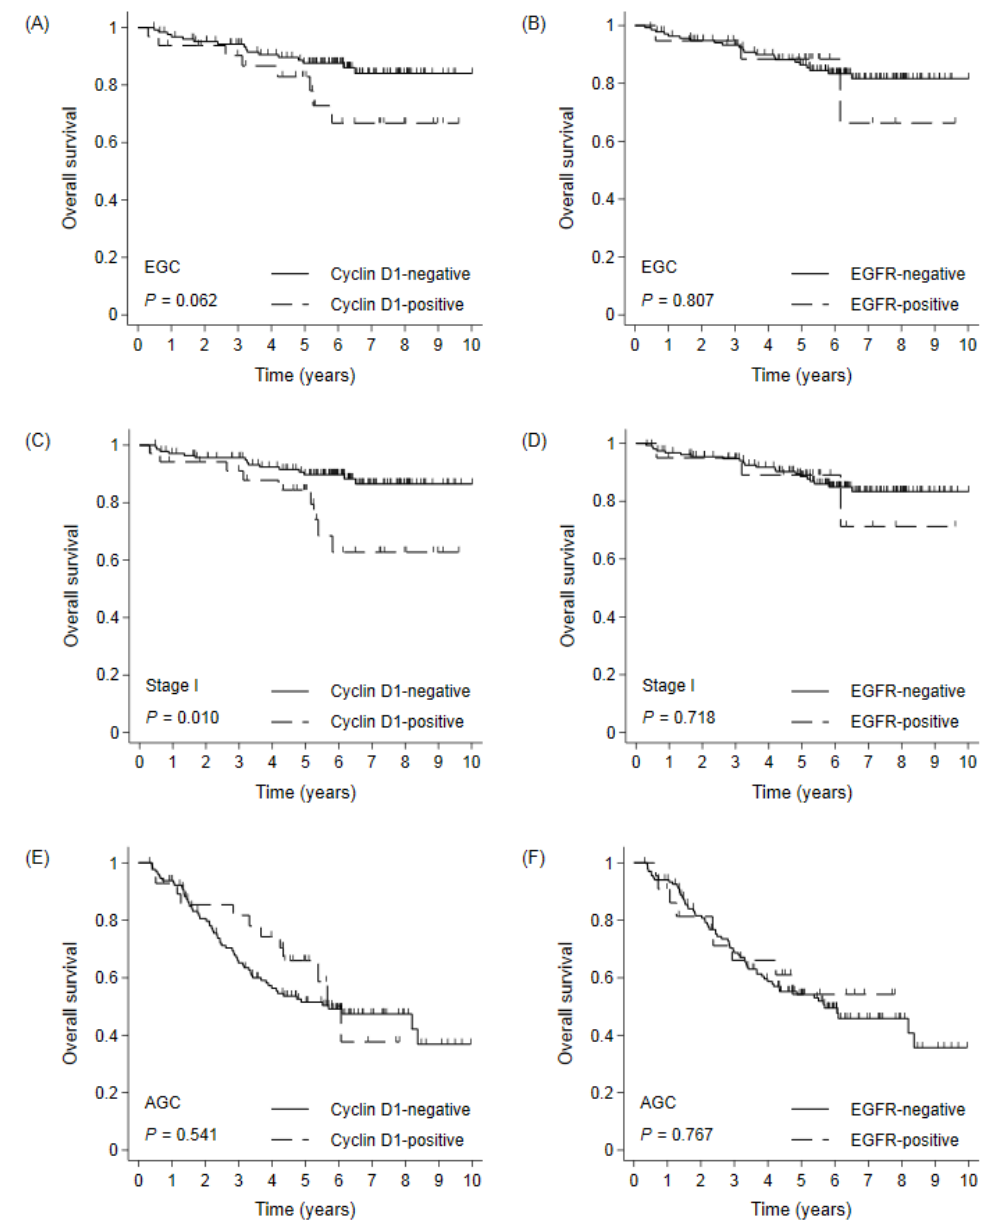
Figure 3. Overall survival by ( A , C , E ) cyclin D1 and ( B , D , F ) EGFR positivity in EGC, stage I gastric cancer, and AGC. EGC: early gastric cancer; AGC: advanced gastric cancer.